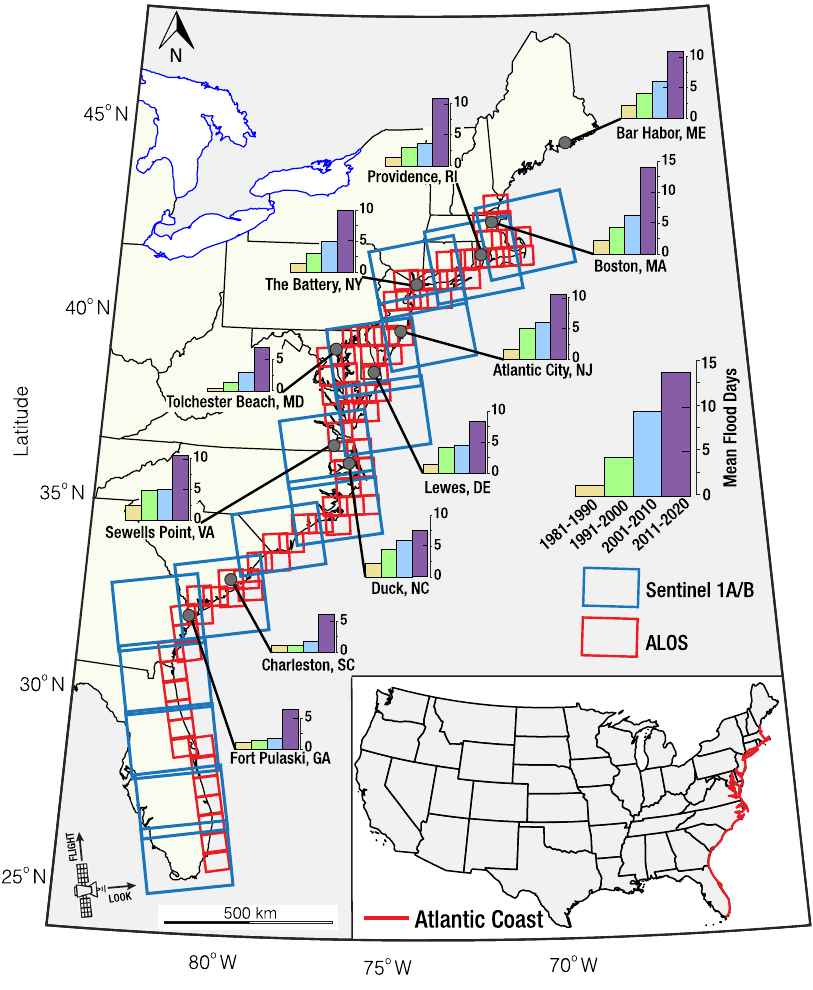
Fig. 1 | Study area and Datasets. The study area is the US Atlantic coast (New Hampshire to Florida). The interferometric datasets include acquisition from Sentinel-1A/B C-band satellites (blue rectangles) spanning 2015 – 2020 obtained in ascending orbits and advanced land observing satellite (ALOS) L-band (red rec- tangles) spanning 2007 – 2011 and acquisitions obtained in and ascending orbits. The path and frame parameters of the SAR datasets are summarized in Supple- mentarytable1.Frequencyof fl